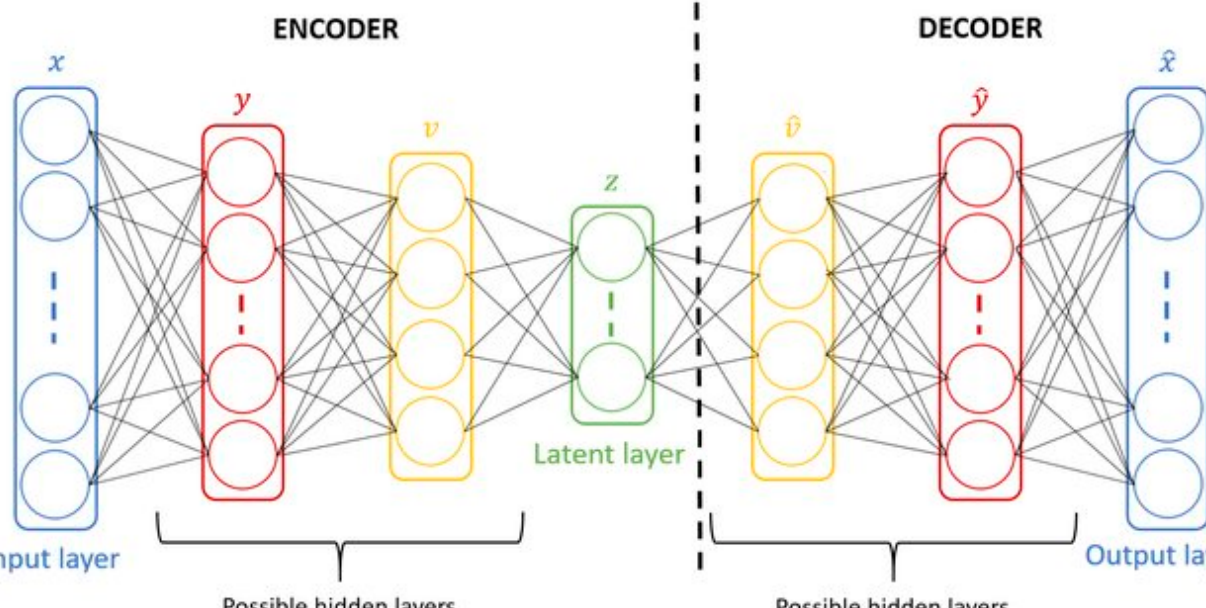
Figure 1. Schematic of an autoencoder [17].